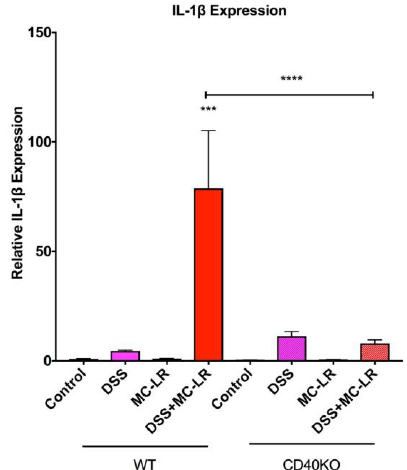
Figure 6. RT-qPCR analysis of pro-inflammatory cytokine IL-1β. Data presented indicate the mean ±